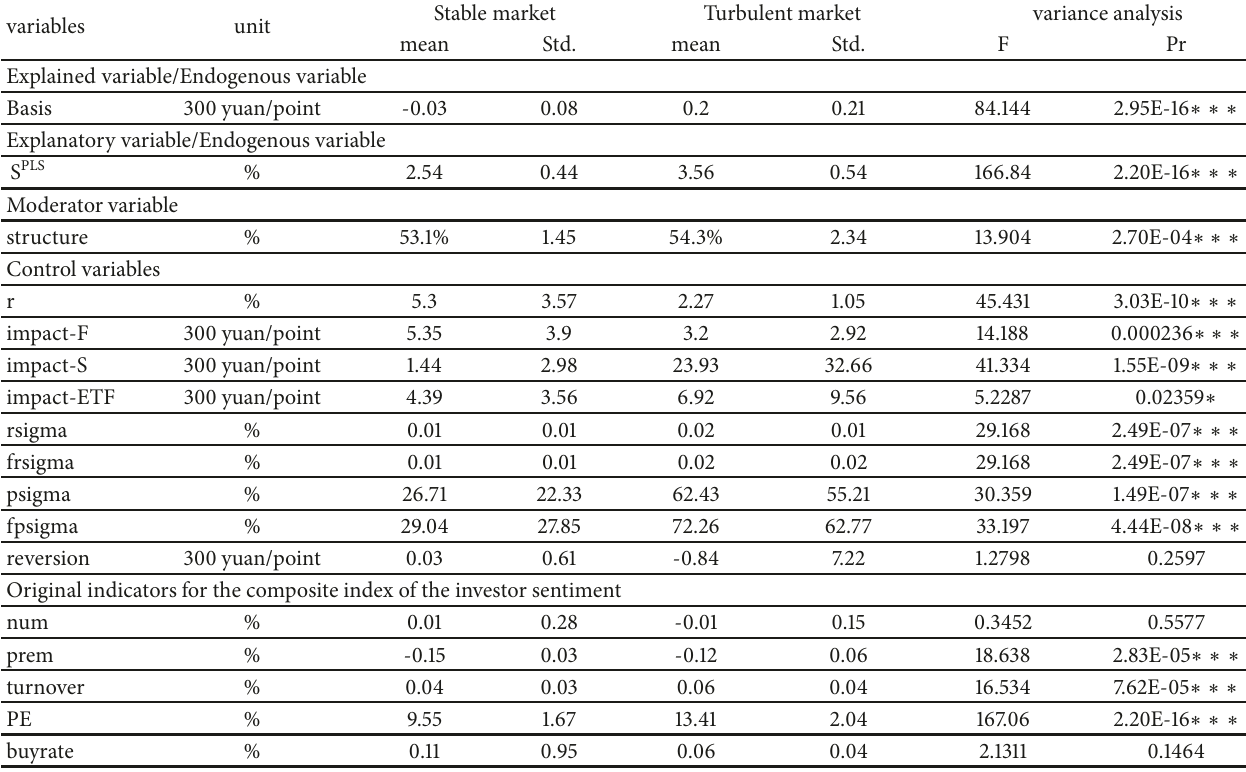
Table 1: Variables descriptive statistics and variance